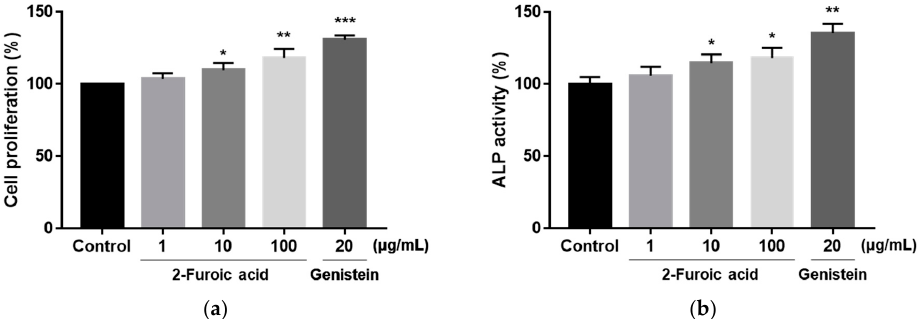
Figure 4. Effect of HR1901-W on the cell viability ( a ) and tartrate-resistant acid phosphatase (TRAP) activity ( b ) of RAW 264.7 cells. All values are expressed as the mean ± standard deviation. * p < 0.05 and ** p < 0.01 when compared with the control.